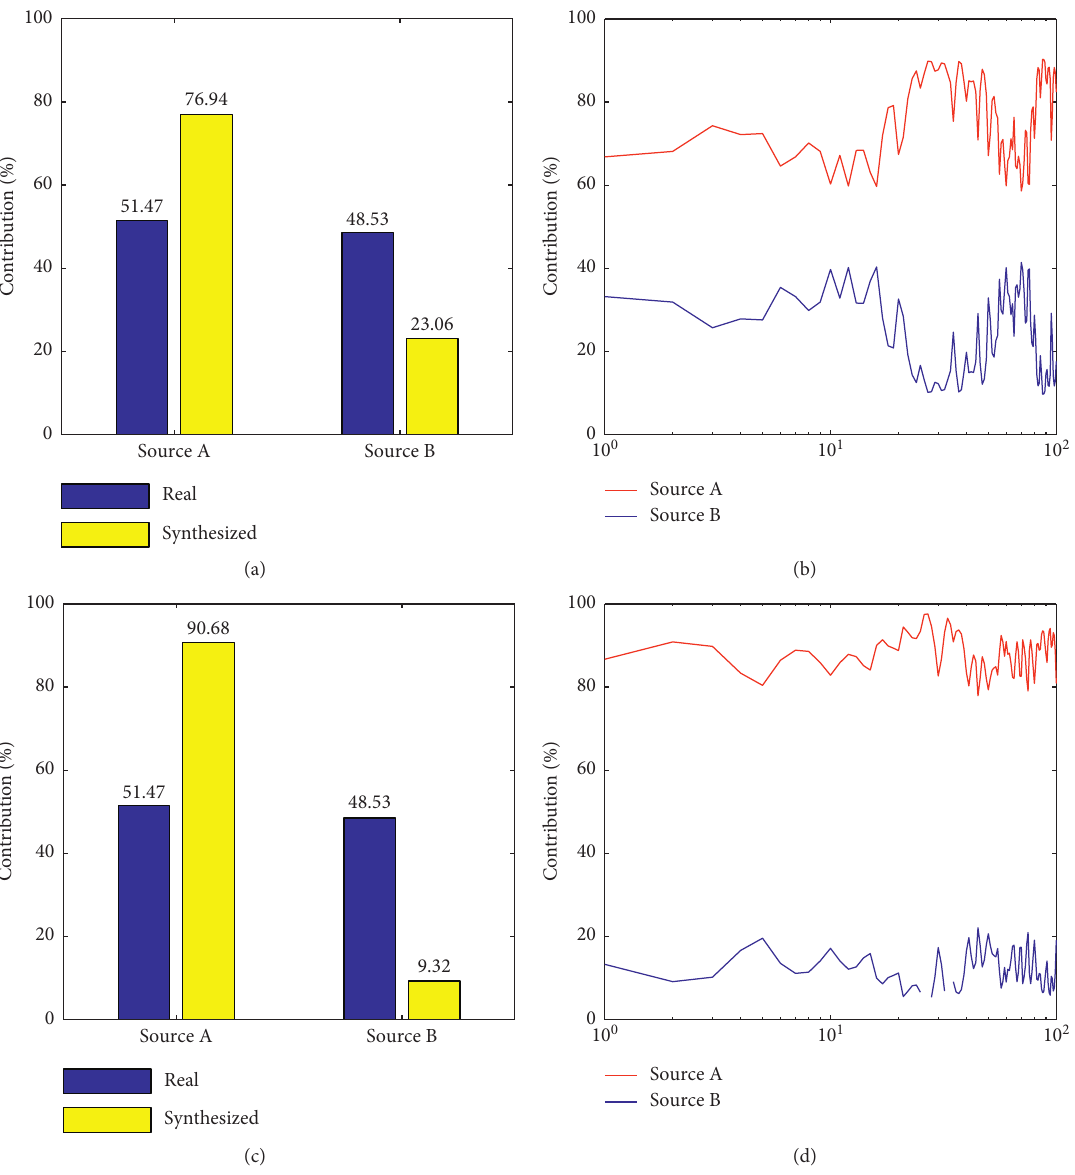
Figure 20: Experimental contribution percentages in function of the correlation factor: (a) correlation � 20%; (b) correlation � 40%; (c) correlation � 60%; (d) correlation � 80%; (e) correlation �